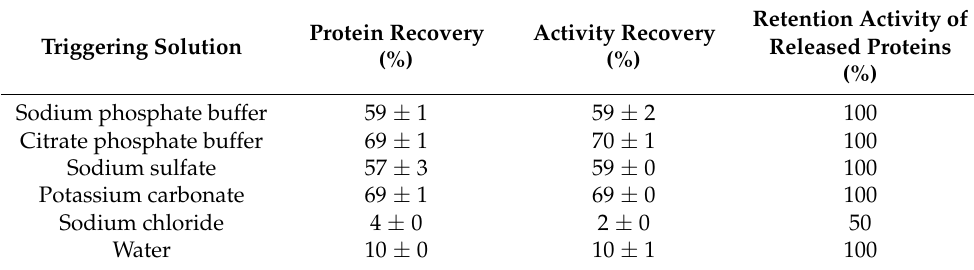
Table 4. Protein and activity recovery of cutinase from LDH/Cut-2/1 after 4 h release in different solutions; the residual activity is calculated with respect to the protein released.